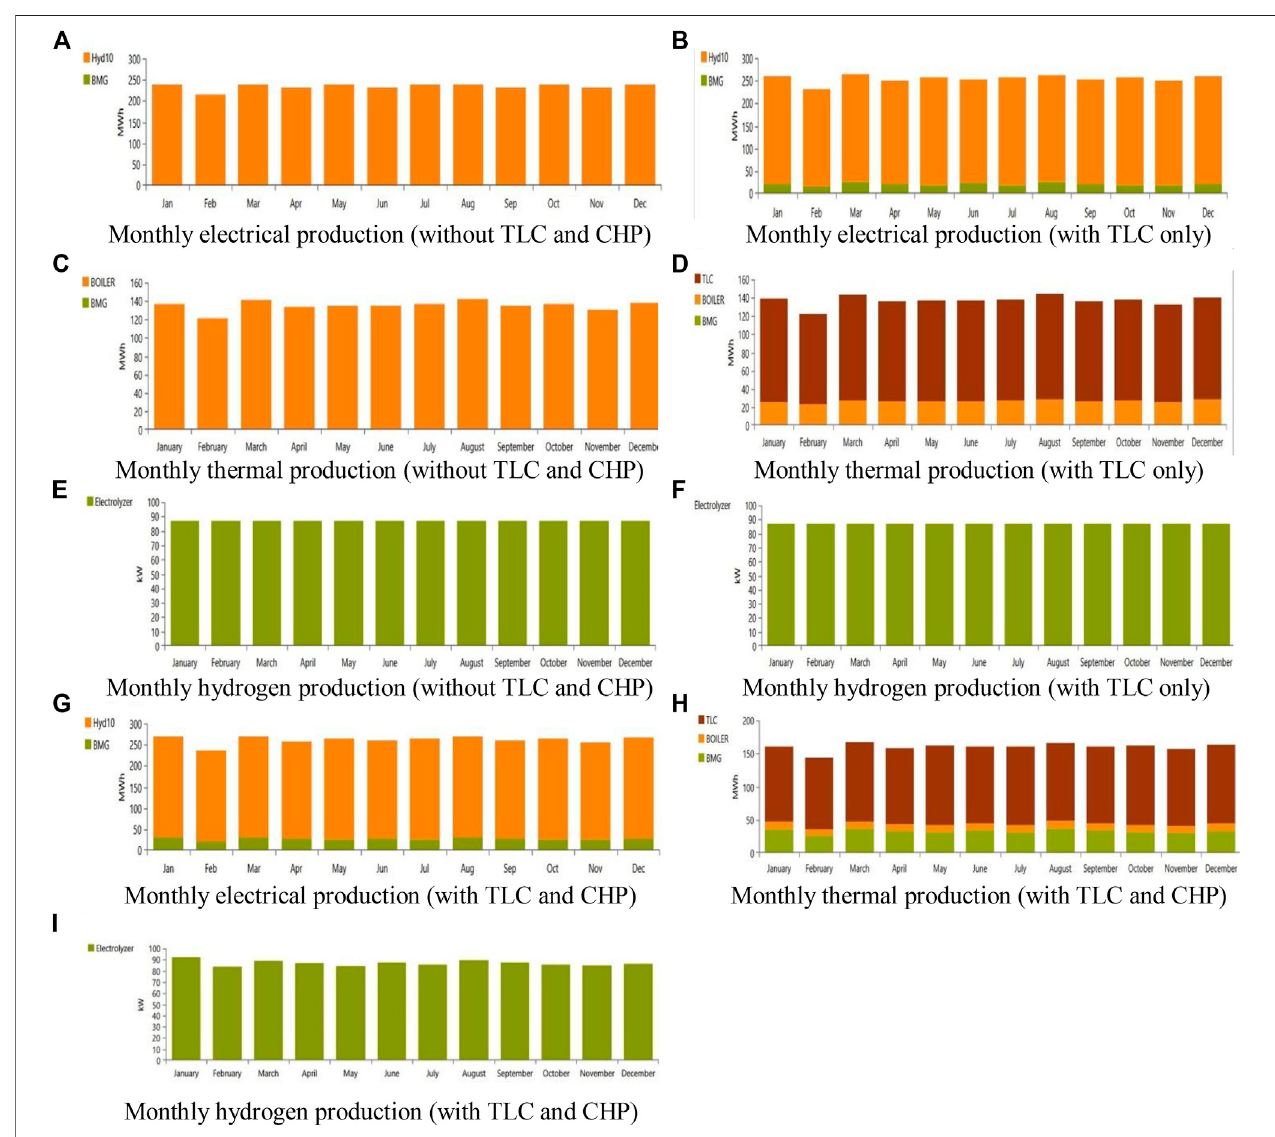
FIGURE 9 | Monthly energy productions. (A) Monthly electrical production (without TLC and CHP). (B) Monthly electrical production (with TLC only). (C) Monthly thermal production (without TLC and CHP). (D) Monthly thermal production (with TLC only). (E) Monthly hydrogen production (without TLC and CHP). (F) Monthly hydrogen production (withTLConly). (G) Monthlyelectricalproduction(withTLCandCHP). (H) Monthlythermalproduction(withTLCandCHP). (i) Monthlyhydrogenproduction(withTLCandCHP).